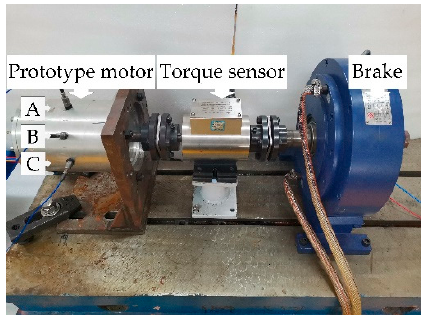
Figure 6. Vibration measurement platform.